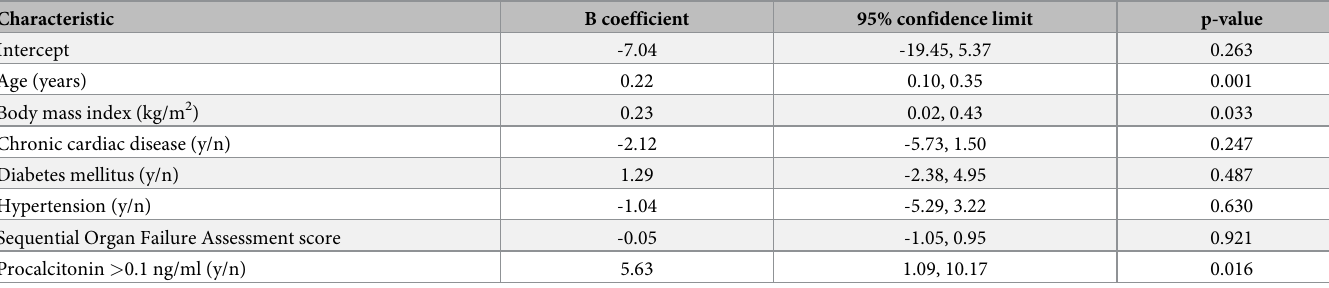
Table 3. Linear regression analysis for days mechanically ventilated as the dependent